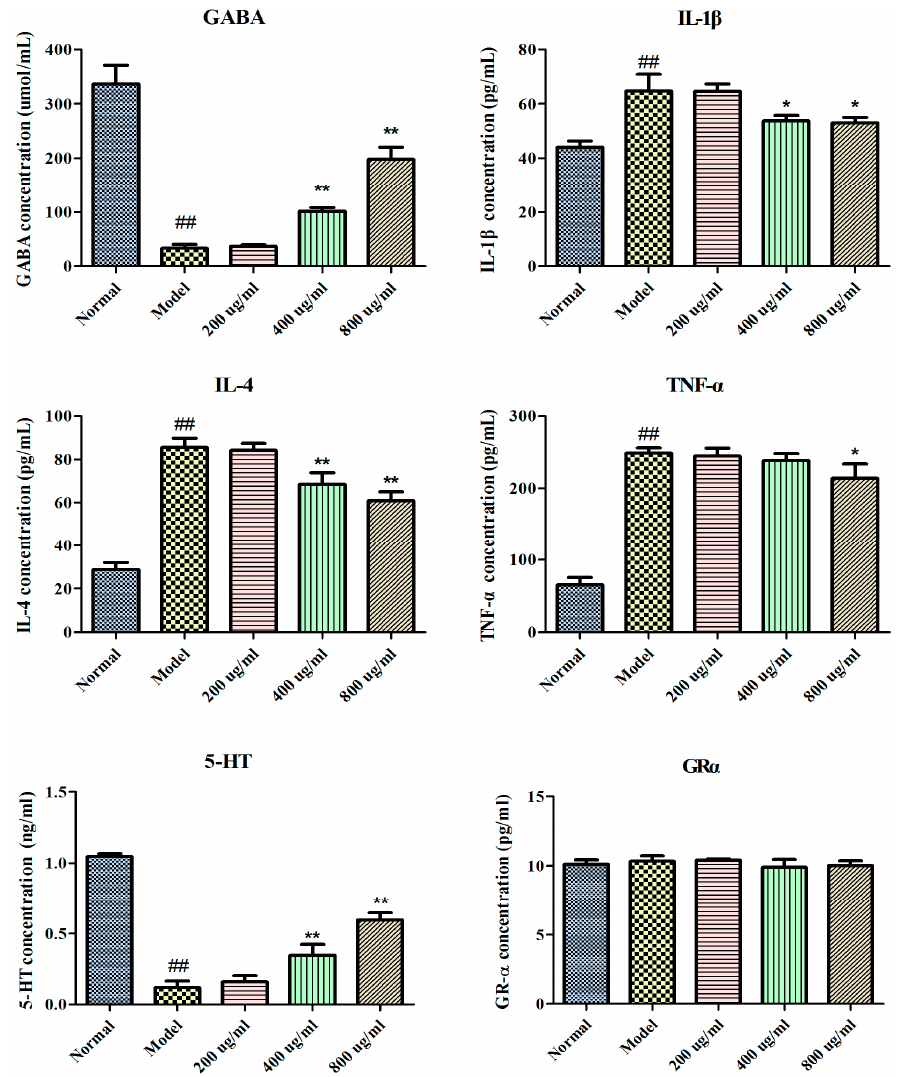
Figure 2. E ff ects of BBPs on GABA, IL-1 β , IL-4, TNF- α , 5-HT and GR α in NGF-induced PC12 cells injured by Glu. The levels of GABA, IL-1 β , IL-4, TNF- α and GR α were determined by corresponding ELISA kits. PC12 cells (induced by 50 ng / mL NGF for 48 h) were treated with BBPs at concentrations of 200, 400 and 800 µ g / mL for 24 h, subsequently subjected to Glu at the concentration of 20 mmol / L for a further 24 h. Normal group: NGF-induced cells without BBPs and Glu; Model group: NGF-induced cells without BBPs, but with 20 mmol / L Glu; BBPs: protein extracts in Bombyx batryticatus The values represent mean ± SD ( n = 6). ## P < 0.01, vs. normal group; * P < 0.05 and ** P < 0.01, vs. model